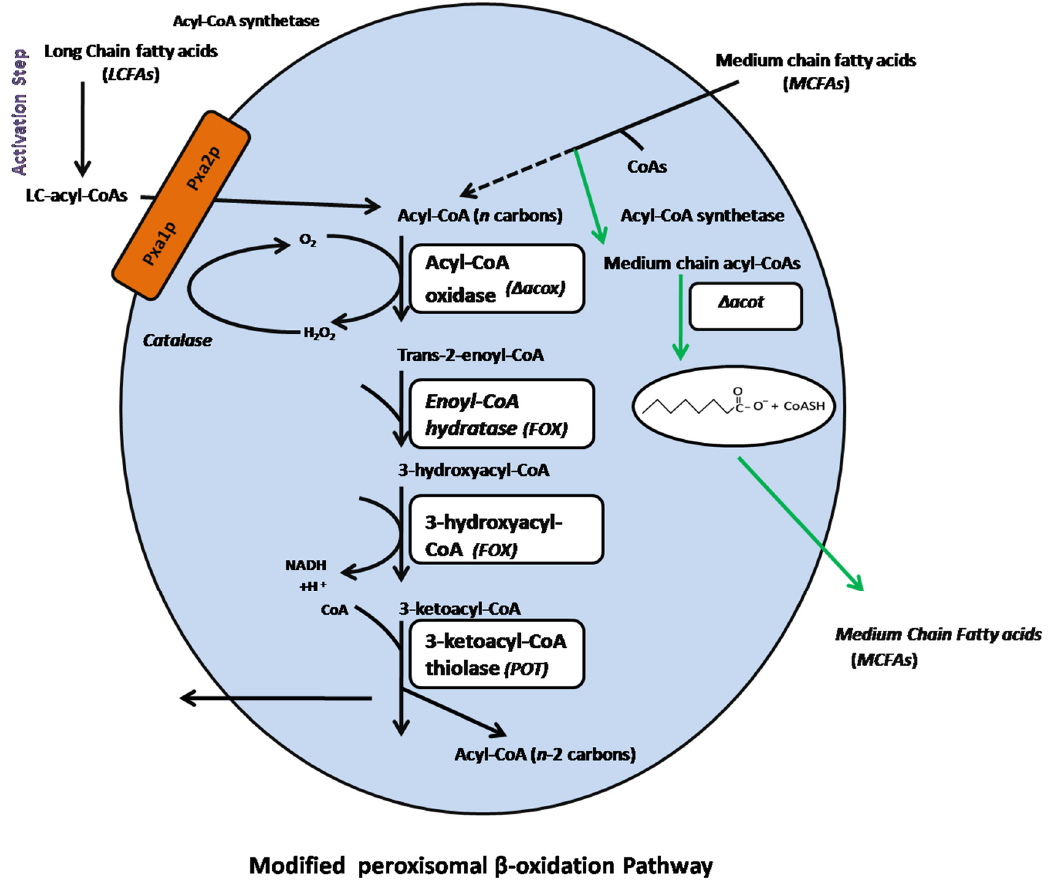
Figure 2. Modification of the β -oxidation pathway in Mucor circinelloides strain MU758 (model adapted from Chen et al. [24]). The black lines (solid + dashed) represent the original pathways for long and medium-chain fatty acid degradation steps in peroxisomes. The green line demonstrates the possible route for MCFAs in peroxisomes after disruption of the ACOX gene (i.e., exhibiting specificity for medium chain acyl-CoAs) (i.e., M-2). The ACOT gene was also disrupted (in the case of M-3), which has a substrate preference for catalyzing the hydrolysis step for acyl-CoA molecules into free fatty acids (FFAs) and coenzyme A (CoAs), eventually facilitating the outward-transportation event in peroxisomes by specific transporters (not shown).